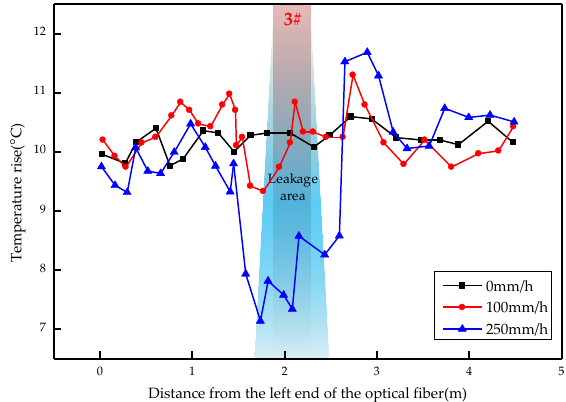
Figure 13. Temperature rise curve at different seepage flow velocity at 4 W. Sensors 2019 , 19 , x FOR PEER REVIEW